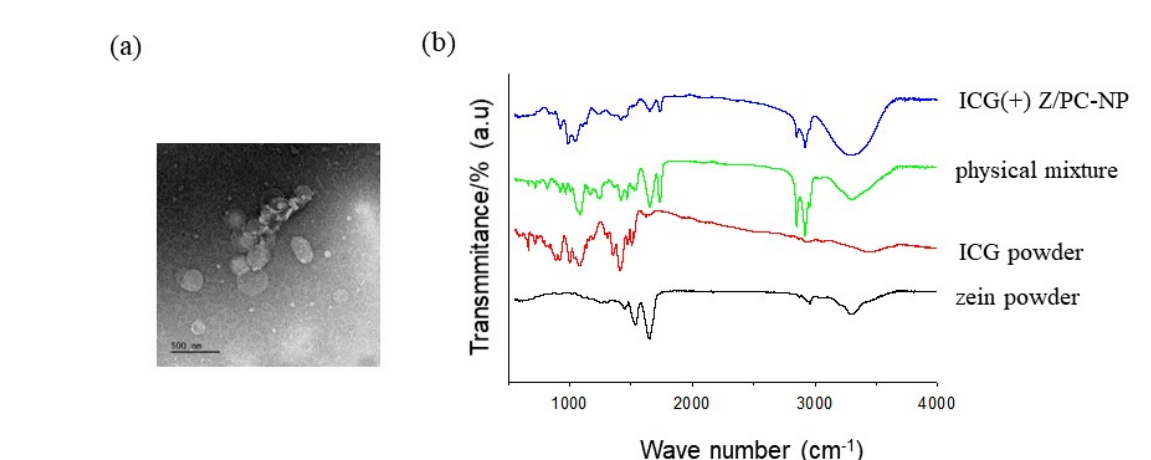
Figure 1. ( a ) A representative negative staining TEM image of ICG-encapsulated Z/PC-NP. Scale bar: 500 nm. ( b ) A FTIR spectrum of zein powder, ICG powder, physical mixture and ICG-encapsulated Z/PC-NP (ICG(+) Z/PC-NP). The Z/PC-NP was prepared from 14.8 mg of lipid (DMPC:CHOL mixture) and 7 mg of zein. The Z/PC-NP samples were freeze-dried before FTIR measurement.